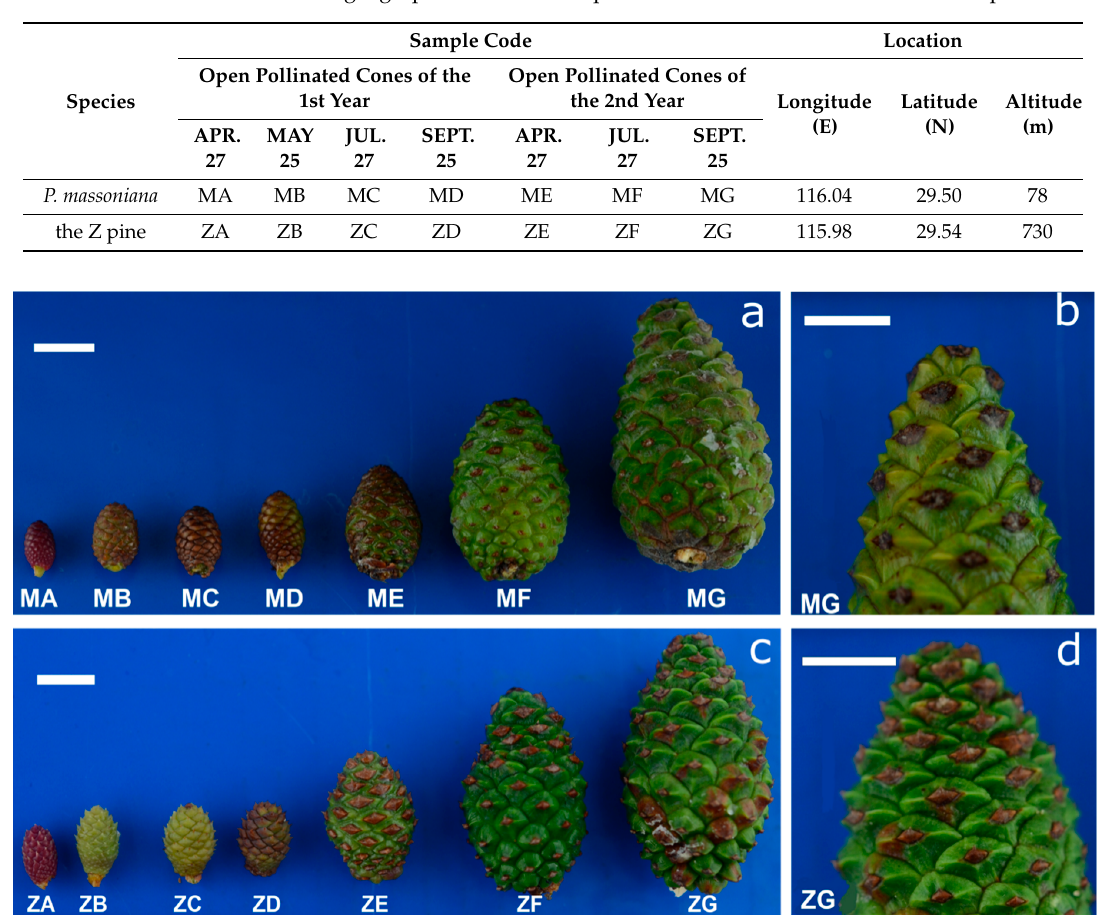
Table 1. Information on the geographical sites of sample collection of P. massoniana and the Z pine.